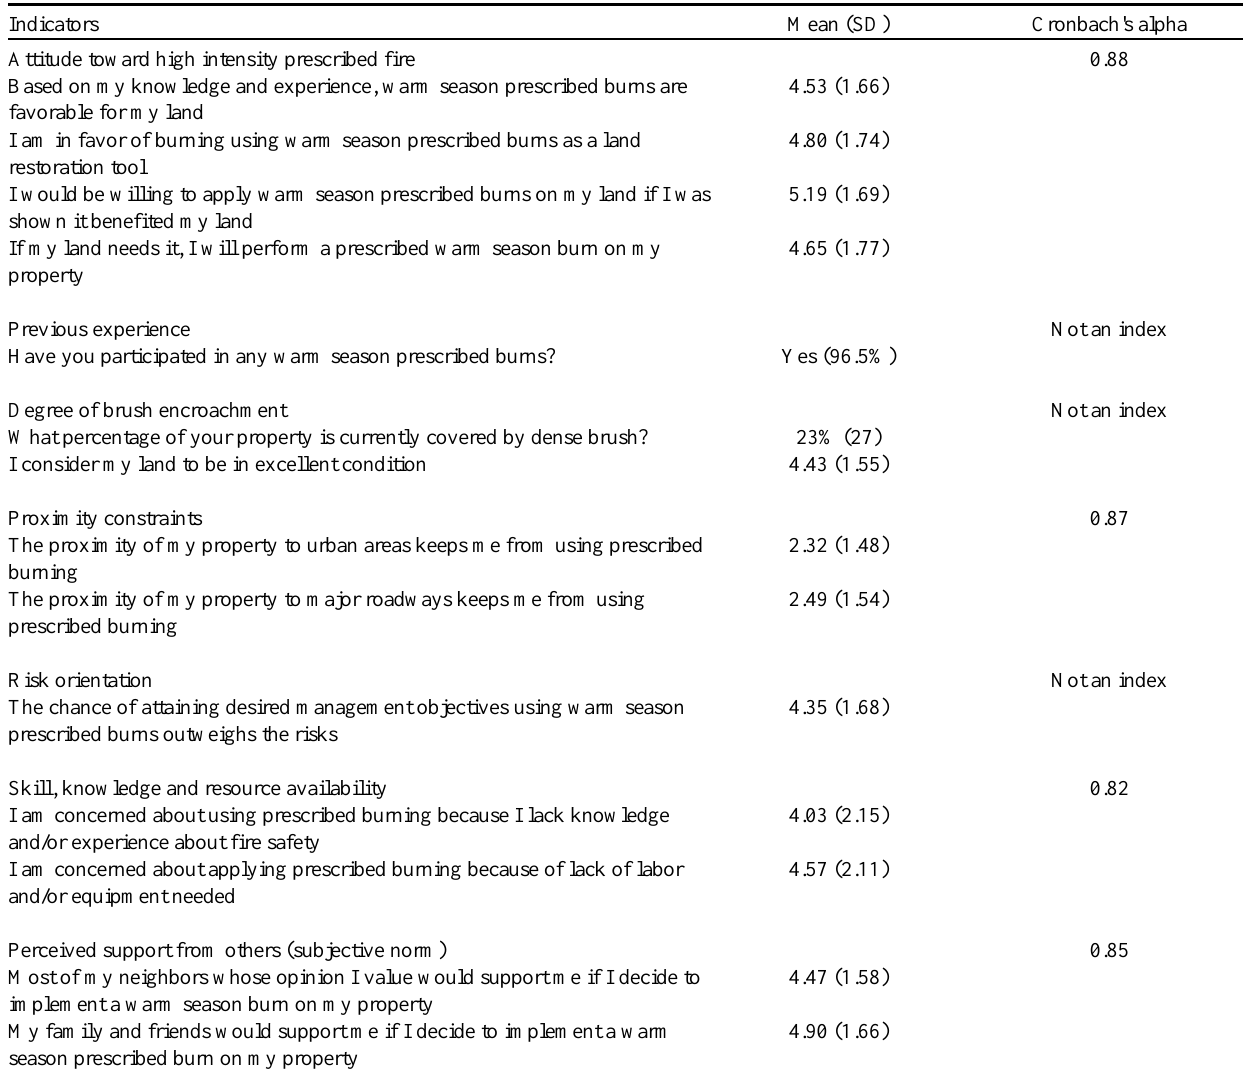
Table 1 . Mean response and Cronbach’s alpha for indicators of experience, attitude toward high-intensity prescribed burning, degree of brush encroachment, proximity constraints, risk orientation, skill, knowledge and resource availability, and perceived support from others for 520 landowners in Texas (1 = strongly disagree to 7 = strongly